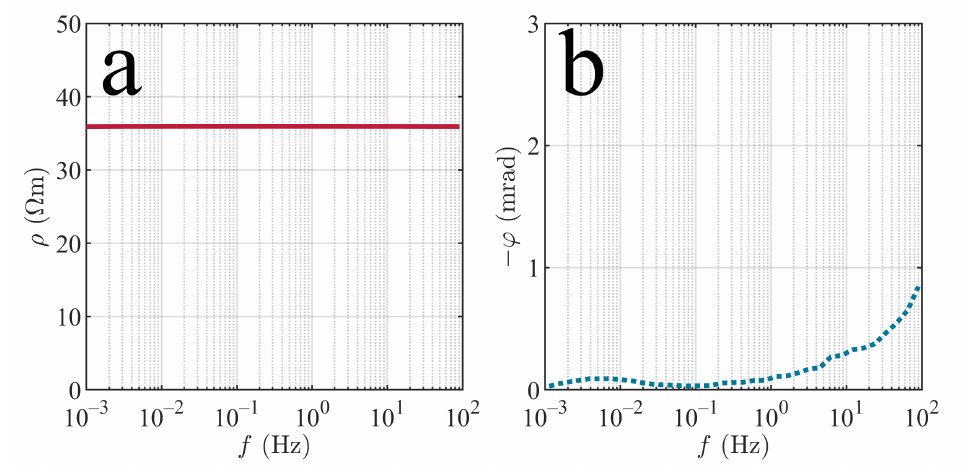
Figure 3. Resistivity ( a ) and phase shift ( b ) vs. frequency of quartz sand saturated with an NaCl solution of 0.1 S/m conductivity, in the sample holder sketched in Figure